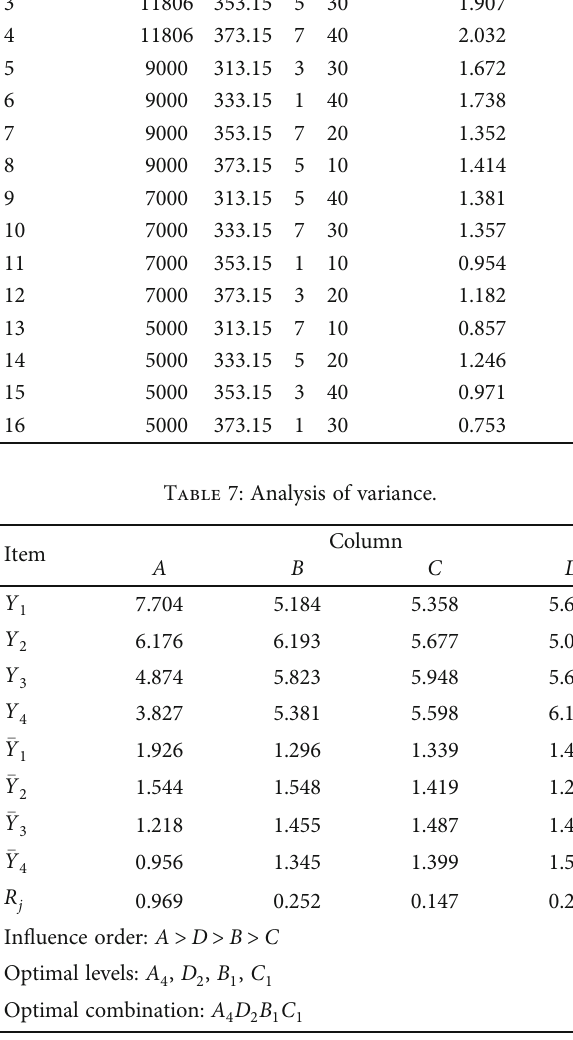
Optimal levels: A 4 , D 2 , B 1 , C 1 Optimal combination: A 4 D 2 B 1 C